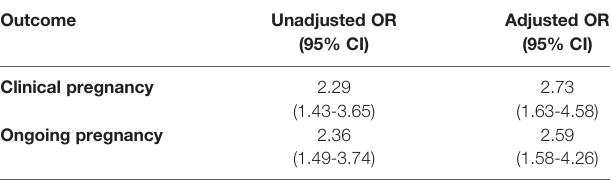
TABLE 4 | Unadjusted and adjusted odds ratios (ORs) of reproductive outcomes following DORI-FET versus mNC-FET. Outcome Unadjusted OR